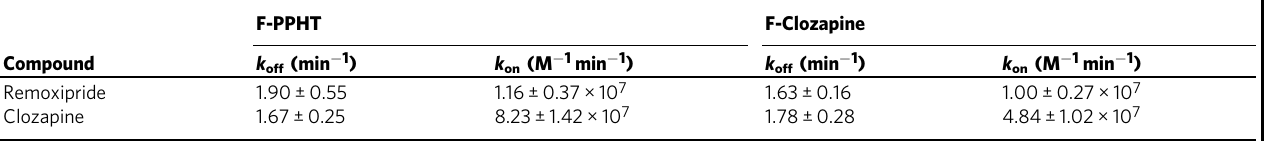
Table 1 Comparison of k on and k off values obtained using the tracers F-PPHT and F-clozapine F-PPHT F-Clozapine